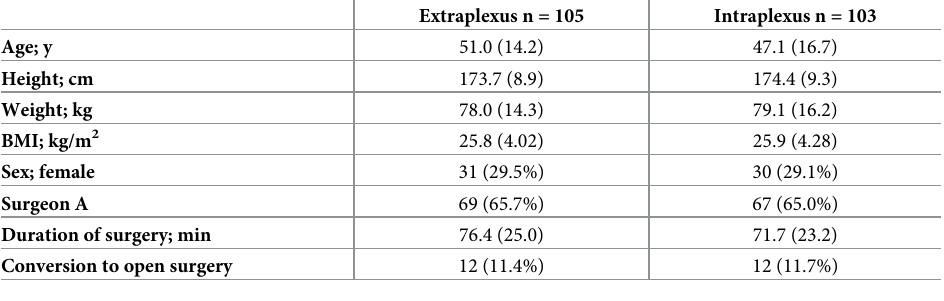
Table 2. Patient demographics and baseline